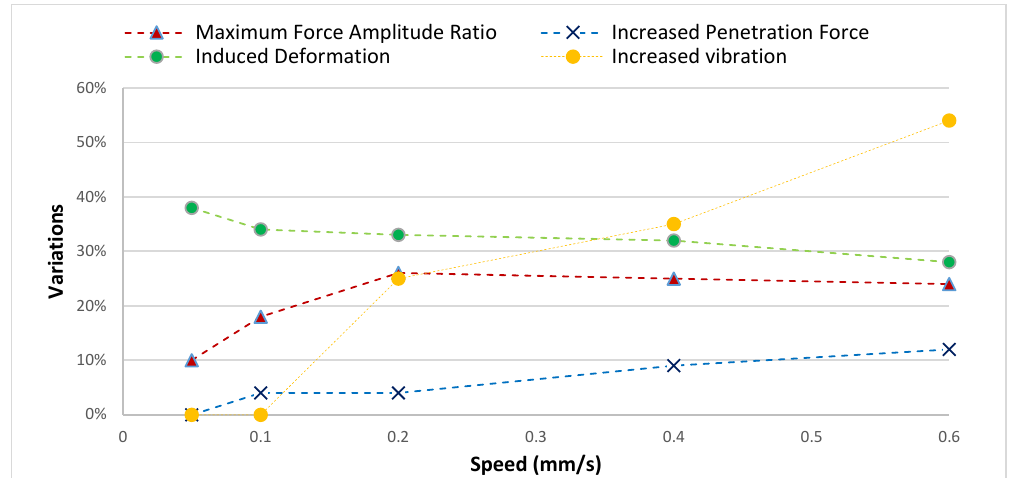
Figure 14. The impact of injection speed on lateral vibration displacement, penetration force, egg deformation, and force amplitude speeds.